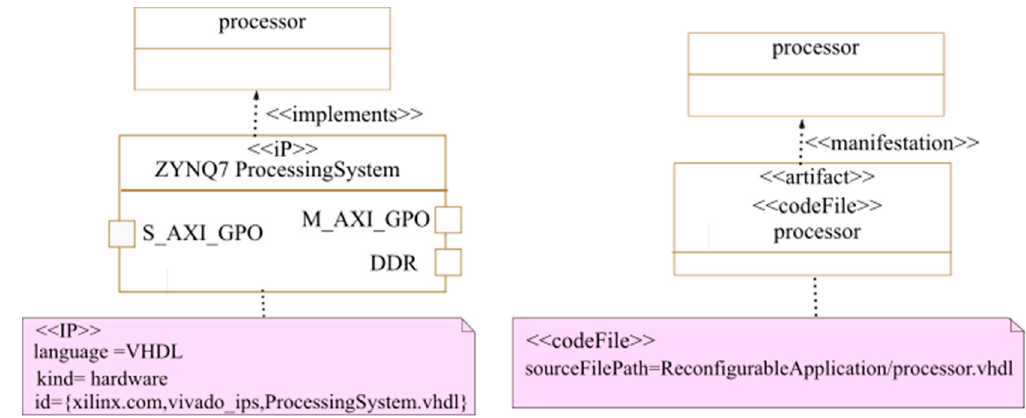
Figure 15. IPs deployment: example of the processor IP.